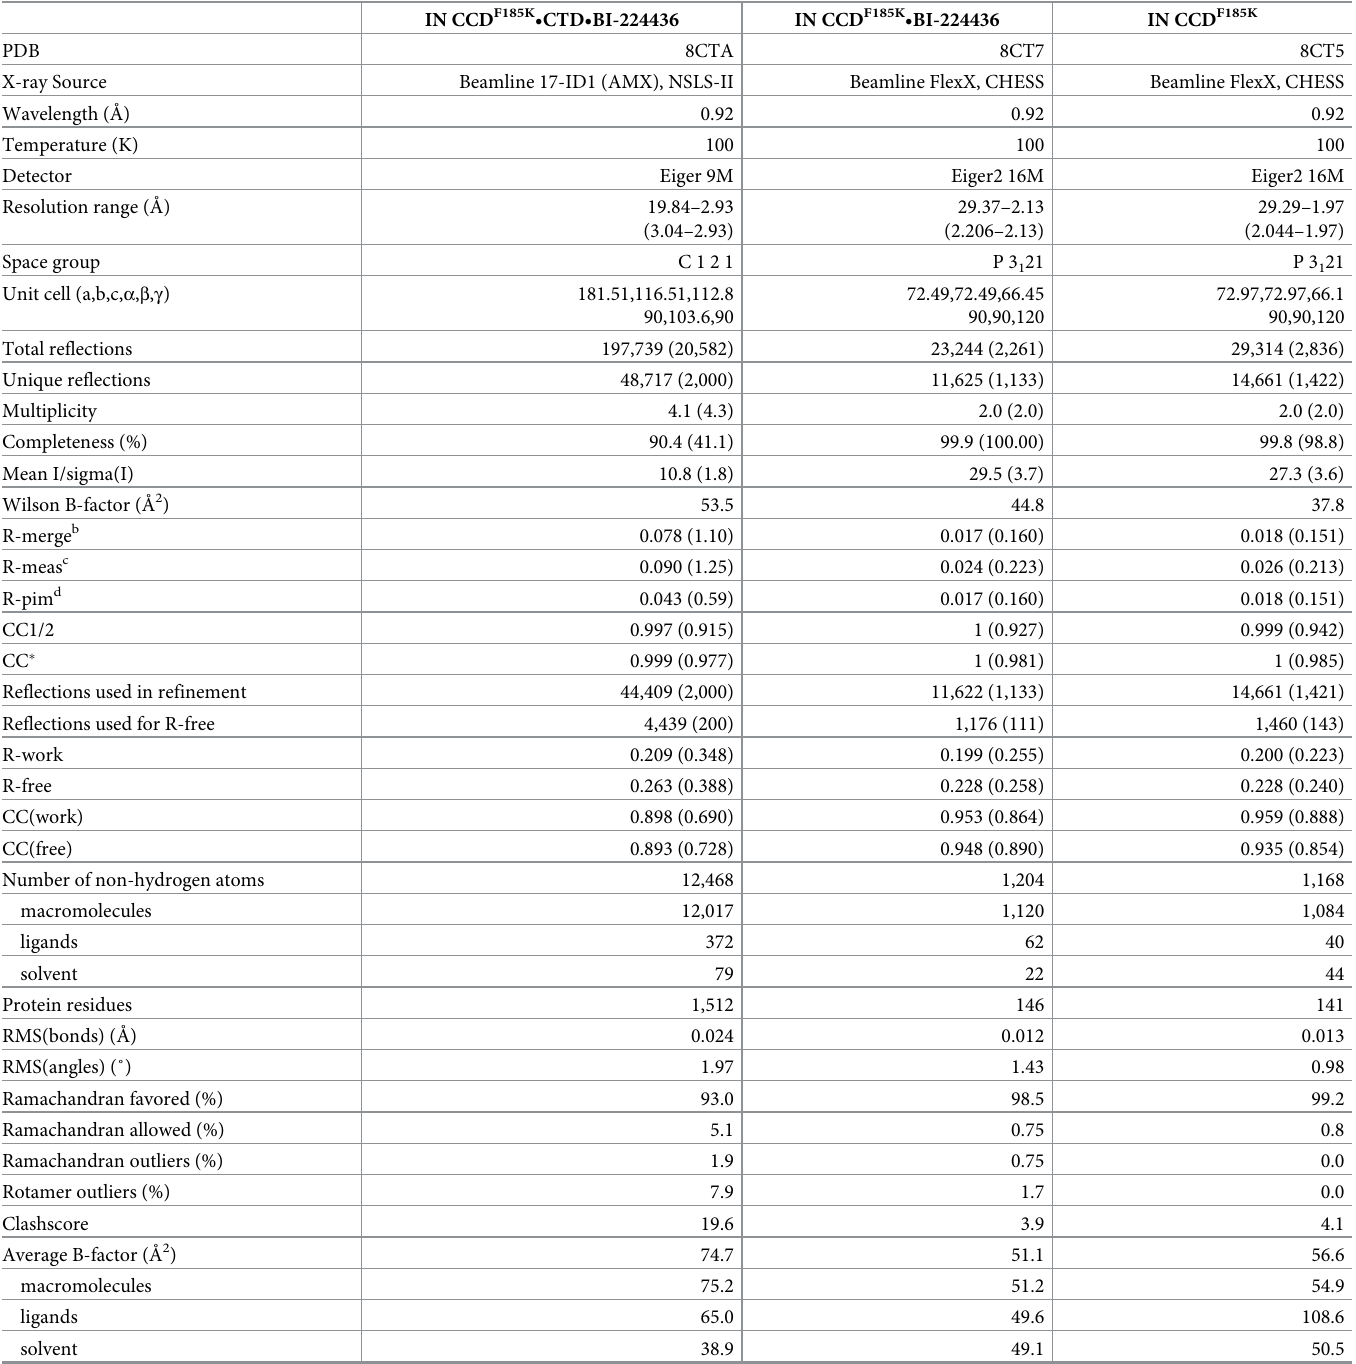
Table 1. Data collection and refinement statistics a